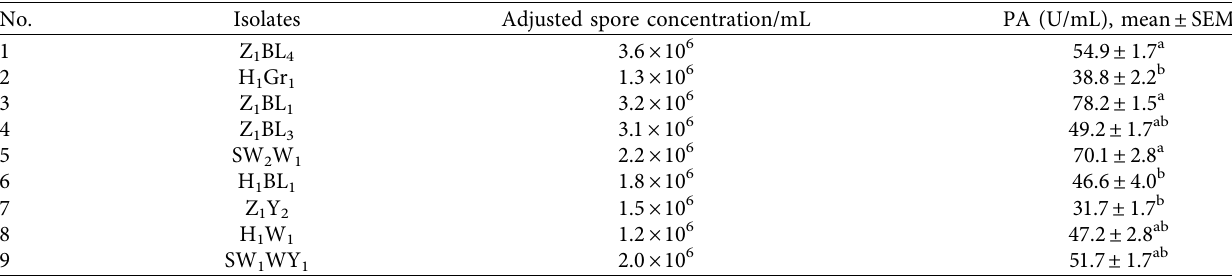
Table 2: Acid protease activity of fungal isolates under